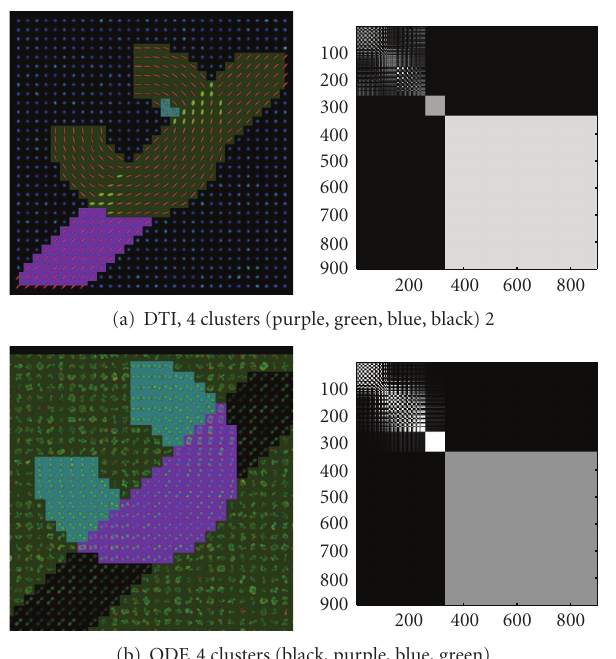
Figure 5: Clustering results in ODF and DT images, only ODF show the correct clustering. In both cases the clustering result and the reordered a ffi nity matrix are shown.